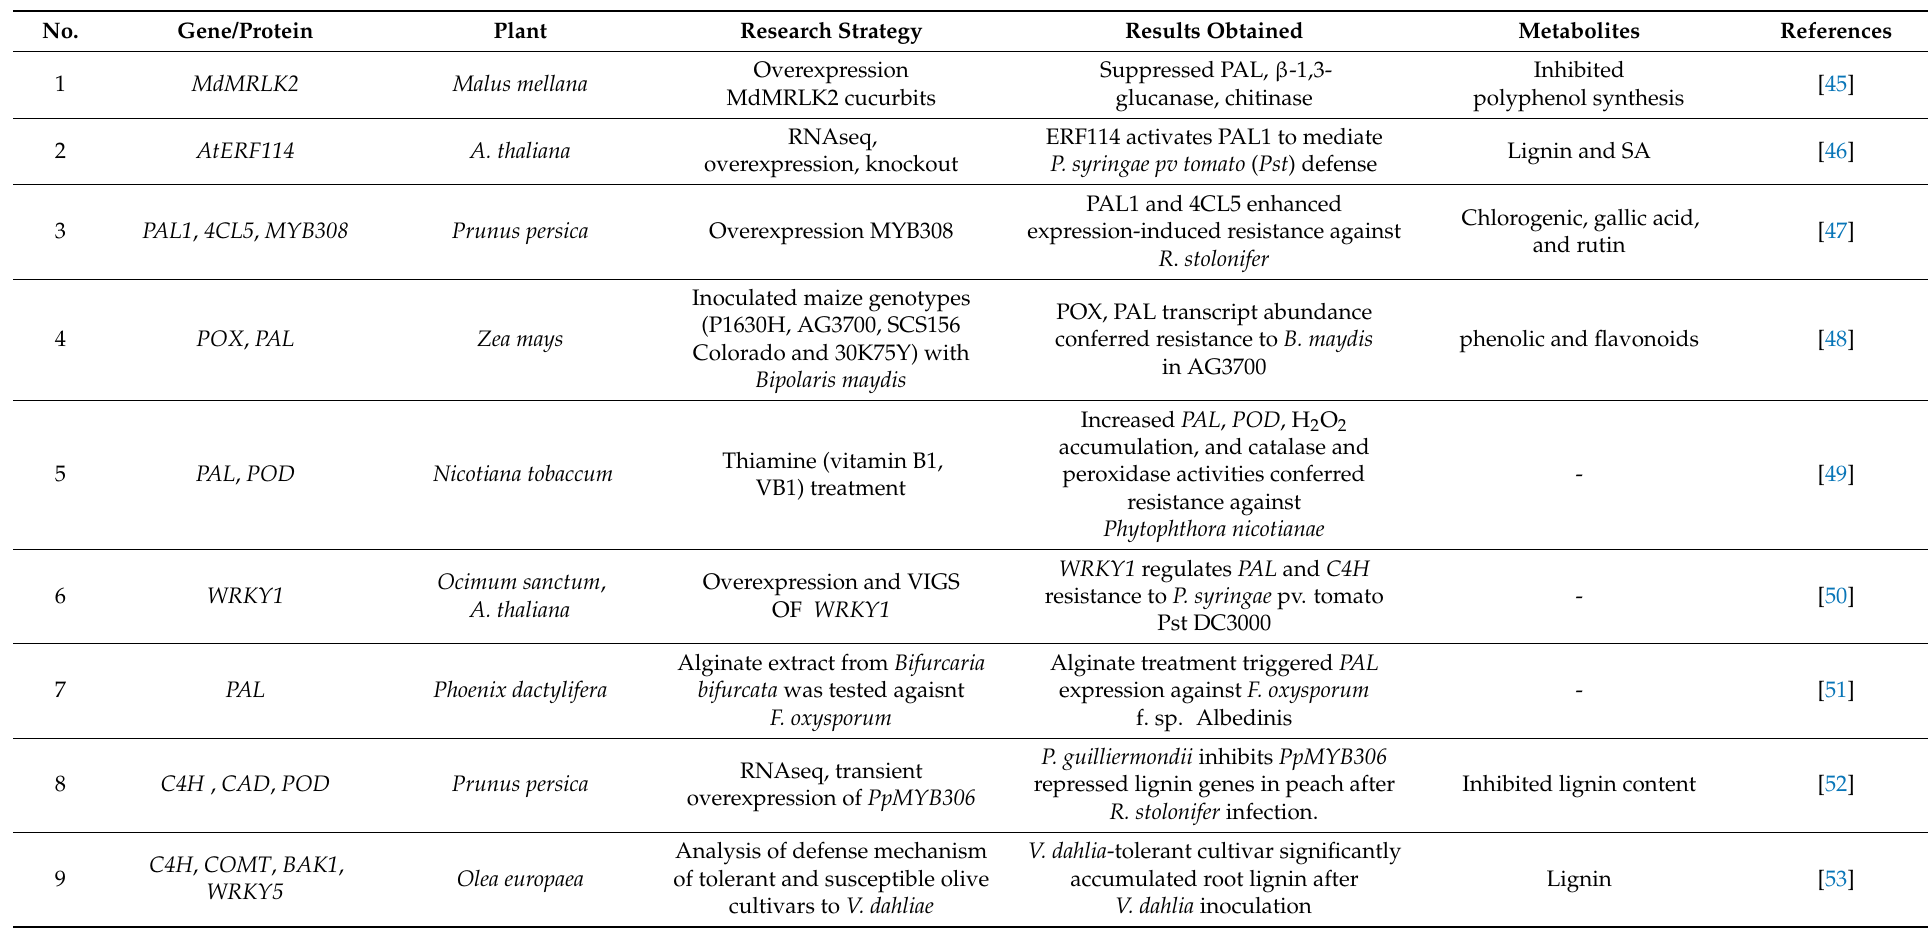
Table 1. Contrition of monolignol biosynthetic regulators to fungal